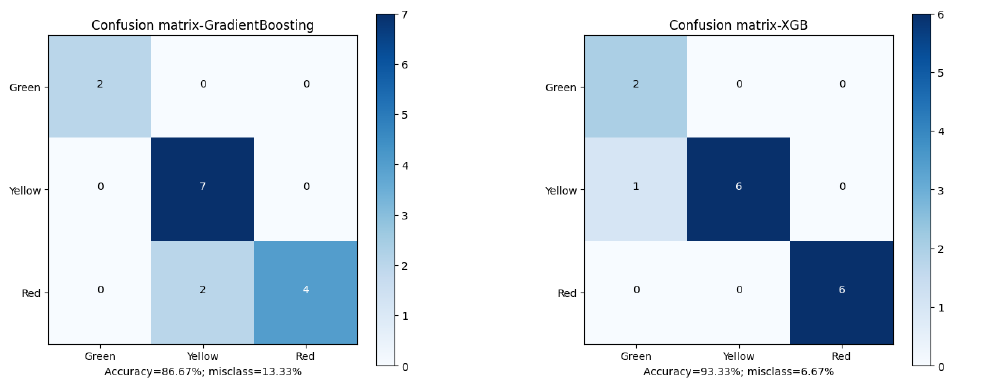
Figure 10. Confusion matrices for GaussianNB and MultinomialNB classifiers.